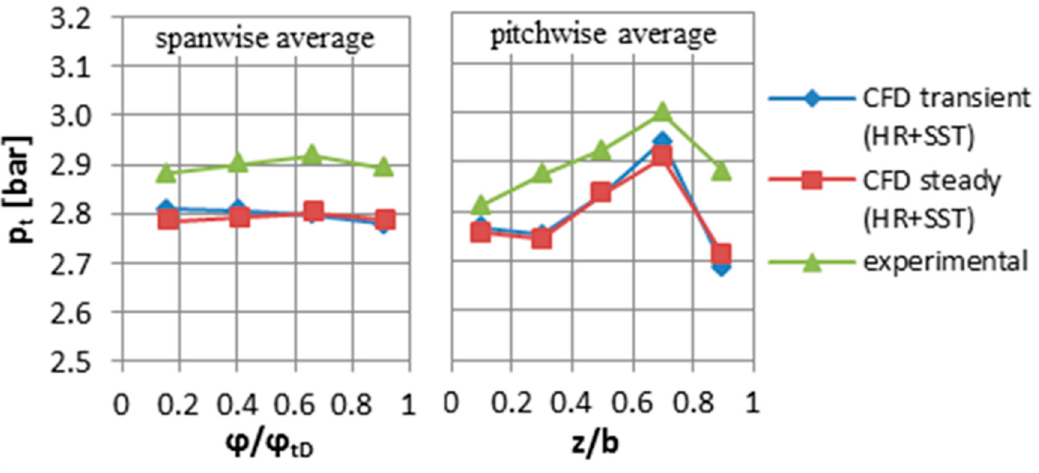
Figure 6. Total pressure at 2M, point M.